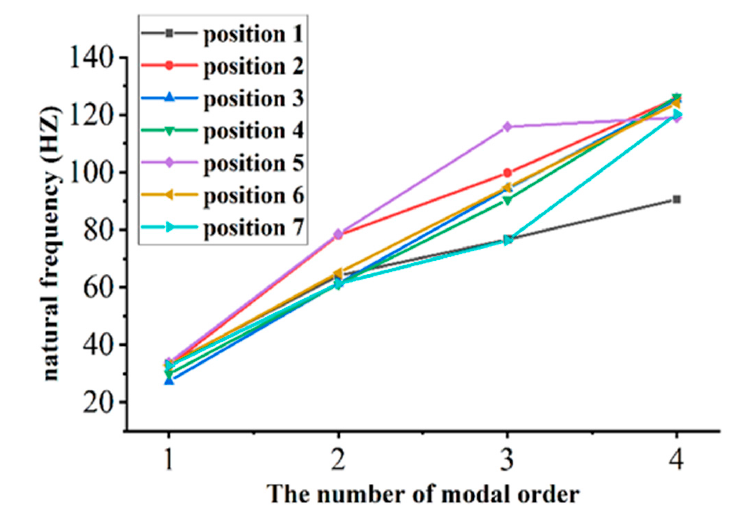
Figure 3. The mode shapes of the first 4 order simulation modes of the PKM at initial position. ( a ) 1st mode shape of vibration; ( b ) 2nd mode shape of vibration; ( c ) 3rd mode shape of vibration; and ( d ) 4th mode shape of vibration.